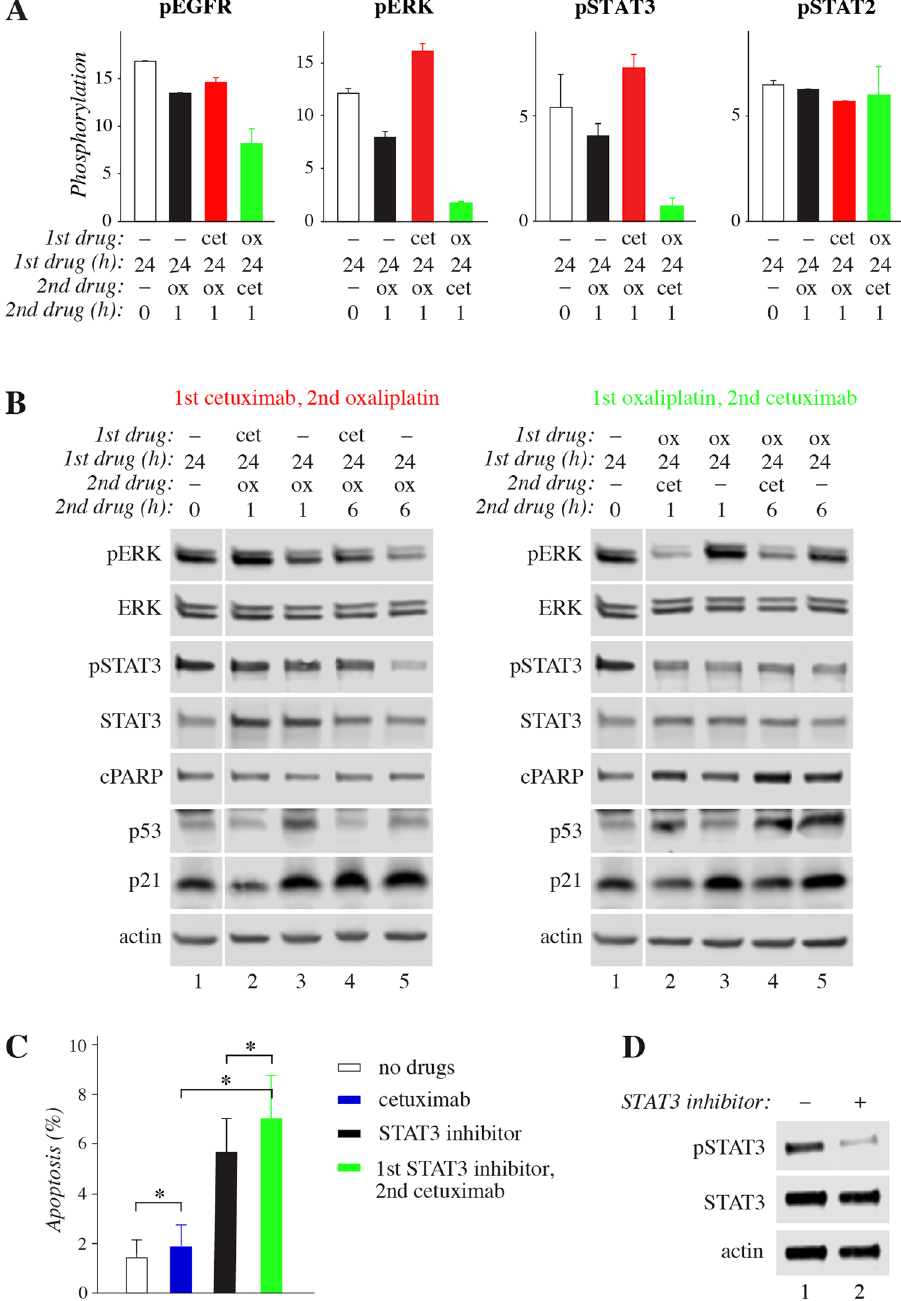
Figure 4. Phosphoarray analysis of signaling responses to sequential treatments. ( A ) HCA7 cells were subjected to different regimens containing 10 μ g/ml cetuximab and/or 50 μ M oxaliplatin: (1) control medium for 24 hours (white), (2) control medium for 24 hours followed by oxaliplatin for 1 hour (black), (3) cetuximab for 24 hours followed by oxaliplatin for 1 hour (red), or (4) oxaliplatin for 24 hours followed by cetuximab for 1 hour (green). Phosphorylation profiles were analyzed using Proteome Profiler Human Phospho-Kinase Array Kit and quantified by densitometry. Mean + / − range is shown for four selected proteins. All results are shown in Suppl. Fig. 3. ( B ) HCA7 cells were subjected to different regimens containing or not 10 μ g/ml cetuximab and/or 50 μ M oxaliplatin as indicated in the figure. The expression or phosphorylation of selected proteins was analyzed by Western blotting. Full-length blots are presented in Supplementary Fig. 8. ( C ) Apoptosis of HCA7 cells was analyzed by annexin V staining after treating the cells first with or without 200 μ M of the STAT3 inhibitor S31- 201 for 8 hours followed by 18 hour treatment with or without 10 μ g/ml cetuximab. Mean + / − SD is shown for three independent experiments. * P <